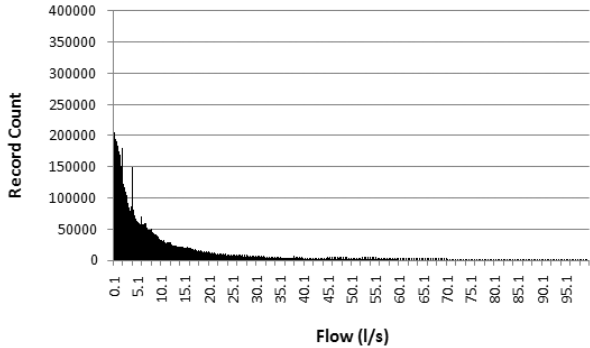
Figure 10. Distribution of flow values.